Question: Provide a one-line summary of what is displayed.
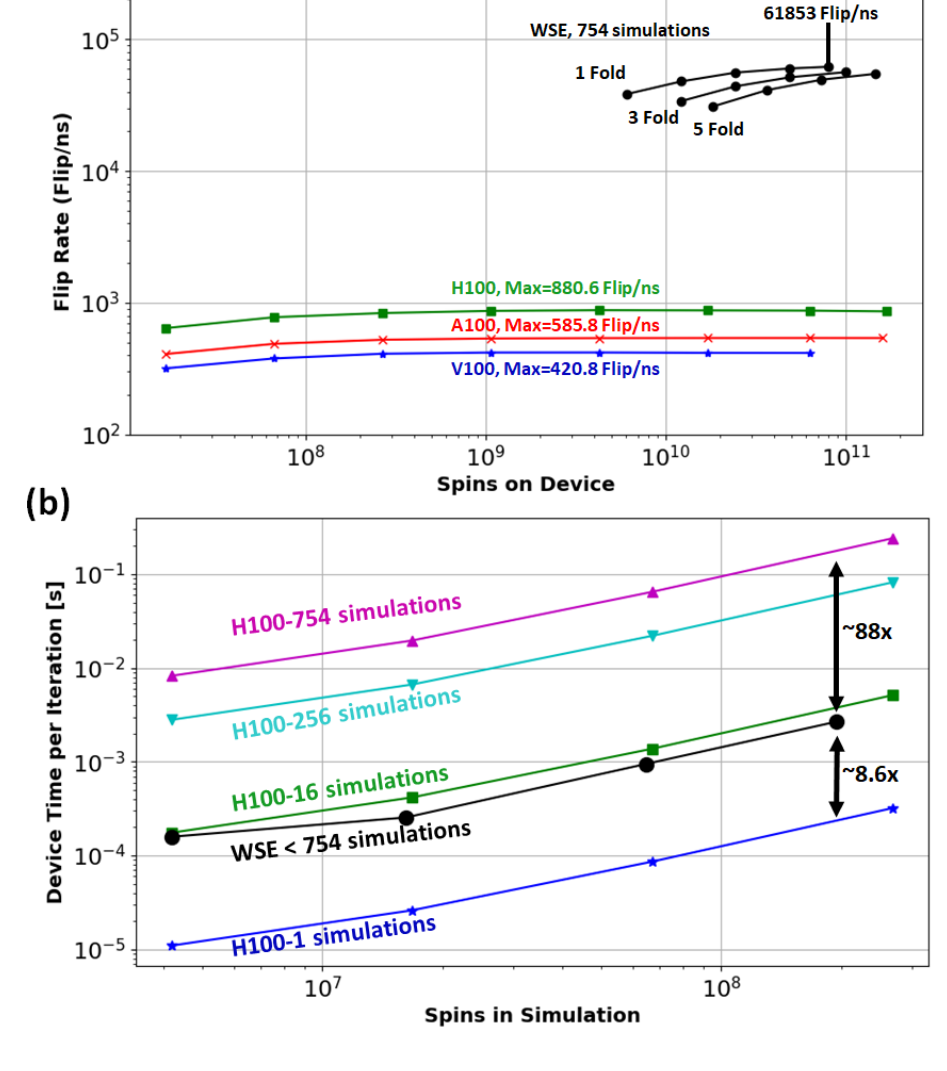
Answer: (a) The flip rate as a function of spins on device. The GPU V100 results are reported in [14] while as the A100 and H100 benchmarks are obtained in this study using the same code as in [14]. The WSE results are obtained using Nfold = 1, 3, and 5 folding. compares the productivity metric, defined as the cumulative device time per iteration to run Nsim simulations, between the H100 and WSE. (b) Productivity metric, defined as the cumulative device time per iteration to run Nsim simulations. The lattice sizes for the WSE measurements are 2048×2048, 3952×4096, 7904×8192, and 11, 586 × 16, 384. The lattice sizes for GPU measurements are 2048 × 2048, 4096 × 4096, 8192 × 8192, and 16, 384 × 16, 384.